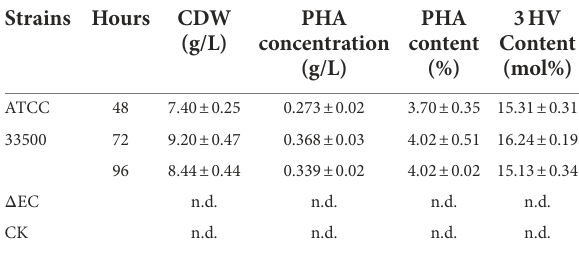
TABLE 2 Determination of the PHA accumulation by gas chromatography.